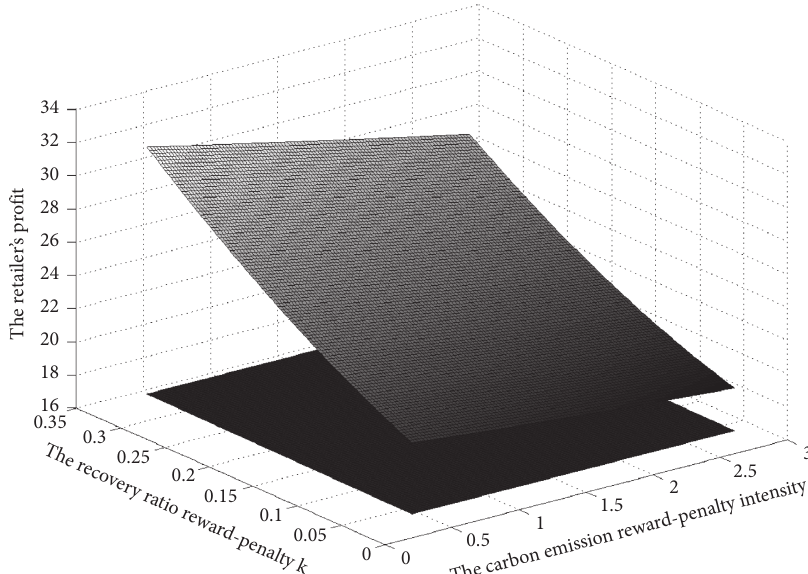
Figure 7: The retailers’ profit π